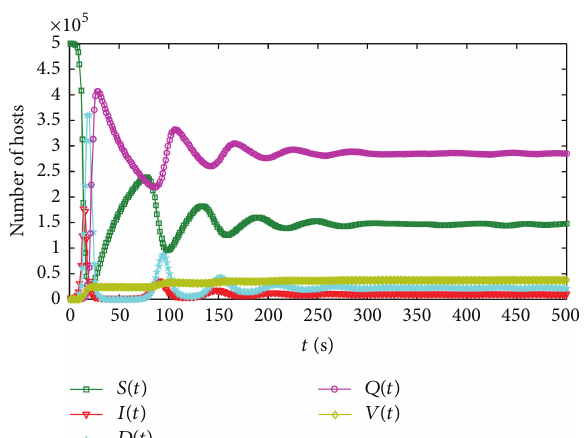
Figure 10: Simulation result of the five kinds of hosts when 𝜏 = 15 .